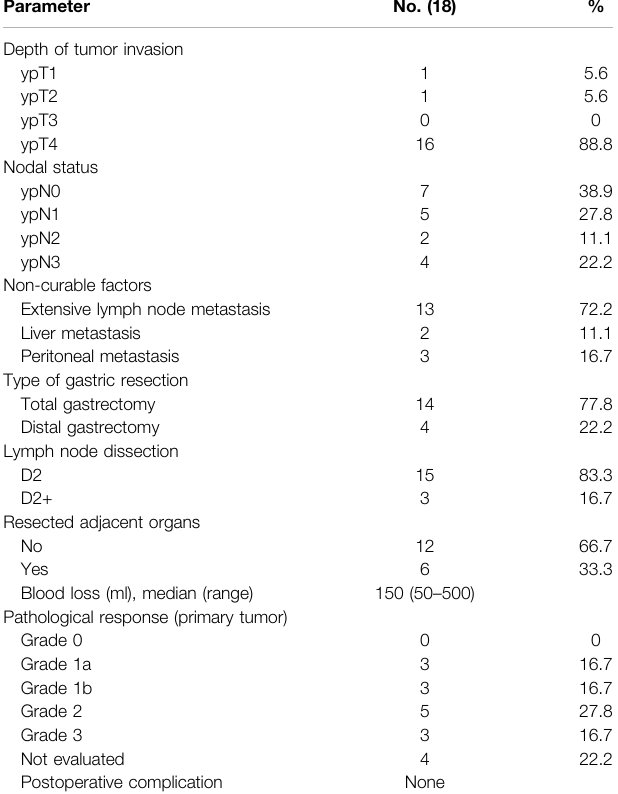
TABLE 4 | Surgical and pathological details.